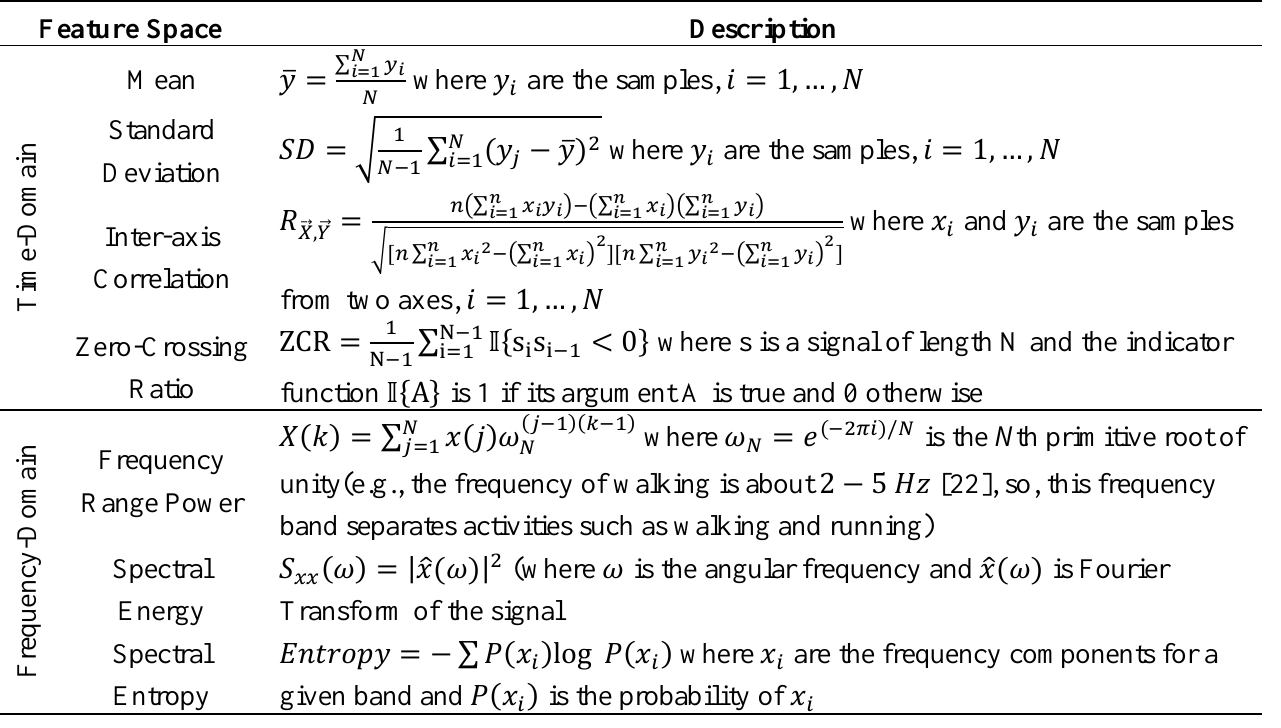
Table 2. The useful time and frequency domain features for context